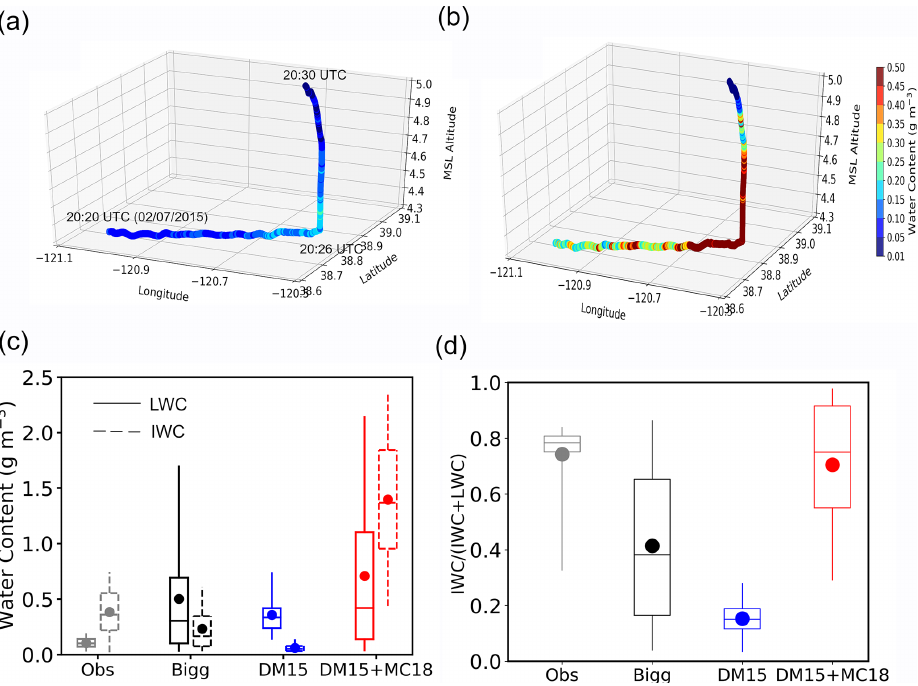
Figure 6. Comparisons of the simulations with aircraft observations. The observed (a) LWC and (b) IWC along the flight track during 20:20–20:30 on 7 February when the aircraft flew through the mixed-phase regime of the postfrontal clouds. (c) LWC (solid) and IWC (dashed) and (d) the glaciation ratios of IWC / (IWC + LWC) from the aircraft measurements (Obs, gray) and simulations of Bigg (black), DM15 (blue), and DM15 + MC18 (red). The boxes show the 25th, median (horizontal lines in the box), and 75th percentiles of the data. The upper and lower whiskers show the 95th and 5th percentiles, respectively. The mean values are denoted by circles. Table 1. The changes in total precipitation, total condensate water path (TWP), liquid water path (LWP), and ice water path (IWP), and cloud fractions (CF), net cloud radiative forcing (CRF) at TOA from DM15 to DM15 + MC18 (i.e., the marine INP effect), as well as the glaciation ratio, i.e., IWC / (LWC + IWC), and the ratios of snow precipitation, i.e., snow / (rain + snow) in mass mixing ratio at the lowest model level from DM15 to DM15 + MC18, at the three AR stages. The percentage changes are calculated following ((DM15 + MC18)– DM15) / DM15 ×